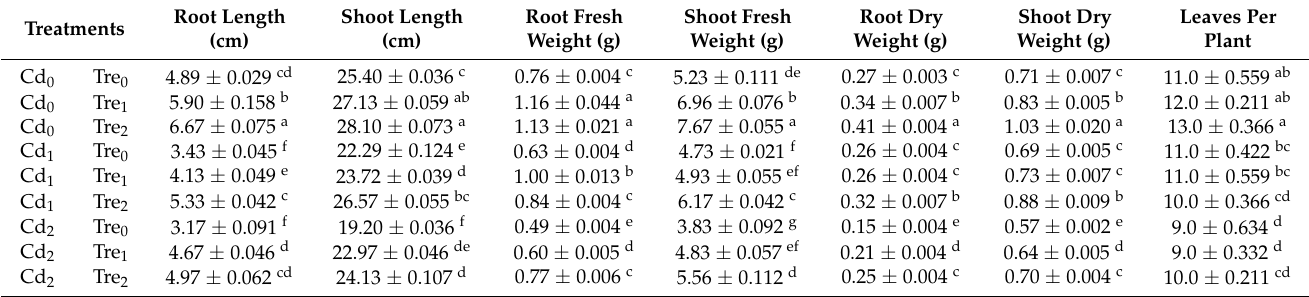
Table 1. Effect of Tre supply on the growth and biomass traits of mung bean grown in soil contami- nated with Cd.